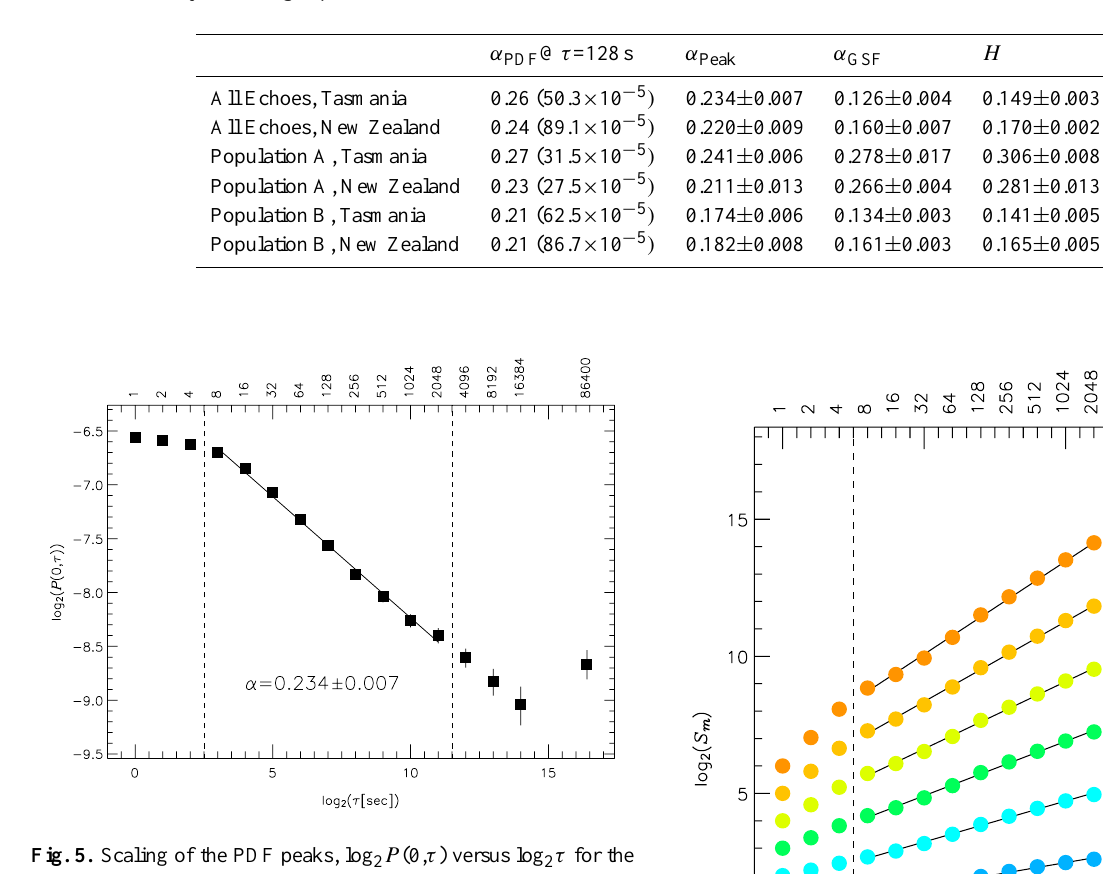
Table 2. Summary of scaling exponents (1 σ fit errors).